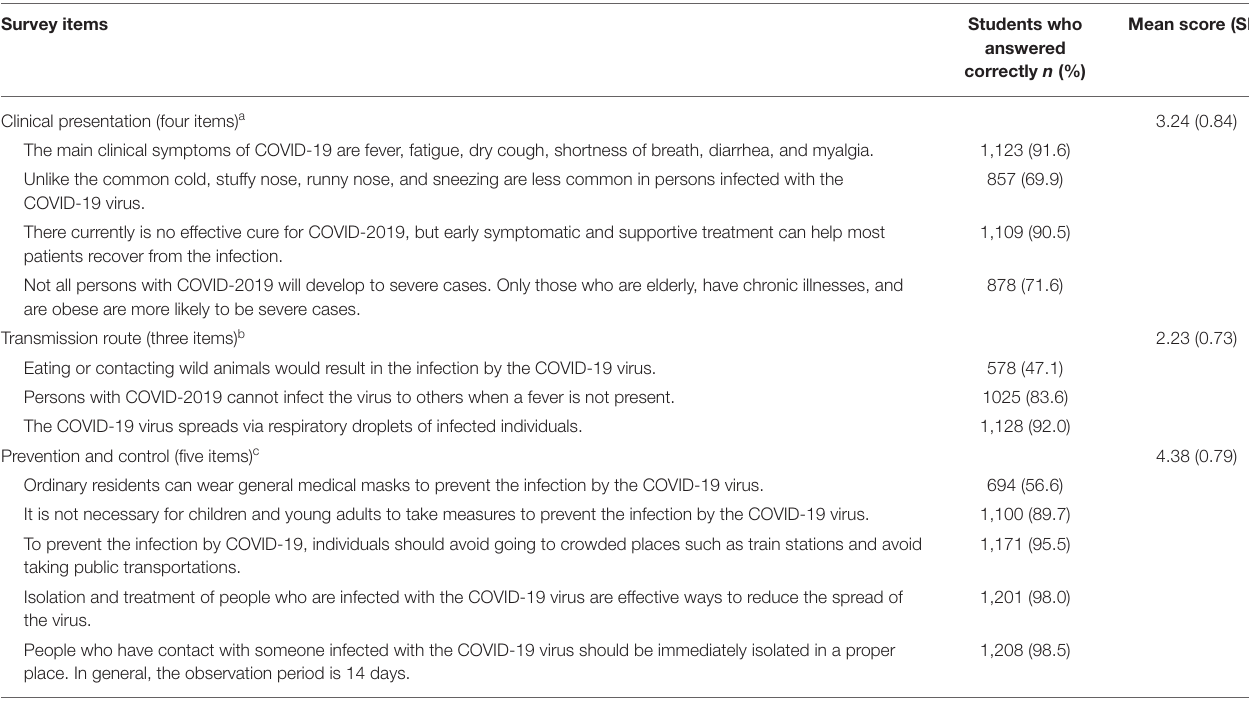
TABLE 2 | Results of the descriptive analyses on the Saudi nursing students’ knowledge regarding COVID-19 ( n =